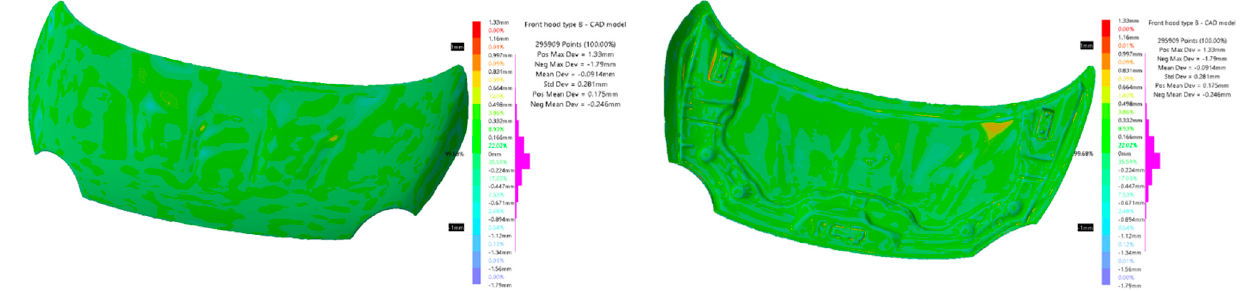
Figure 11. CAD model—scanned model comparison for hood “B”.